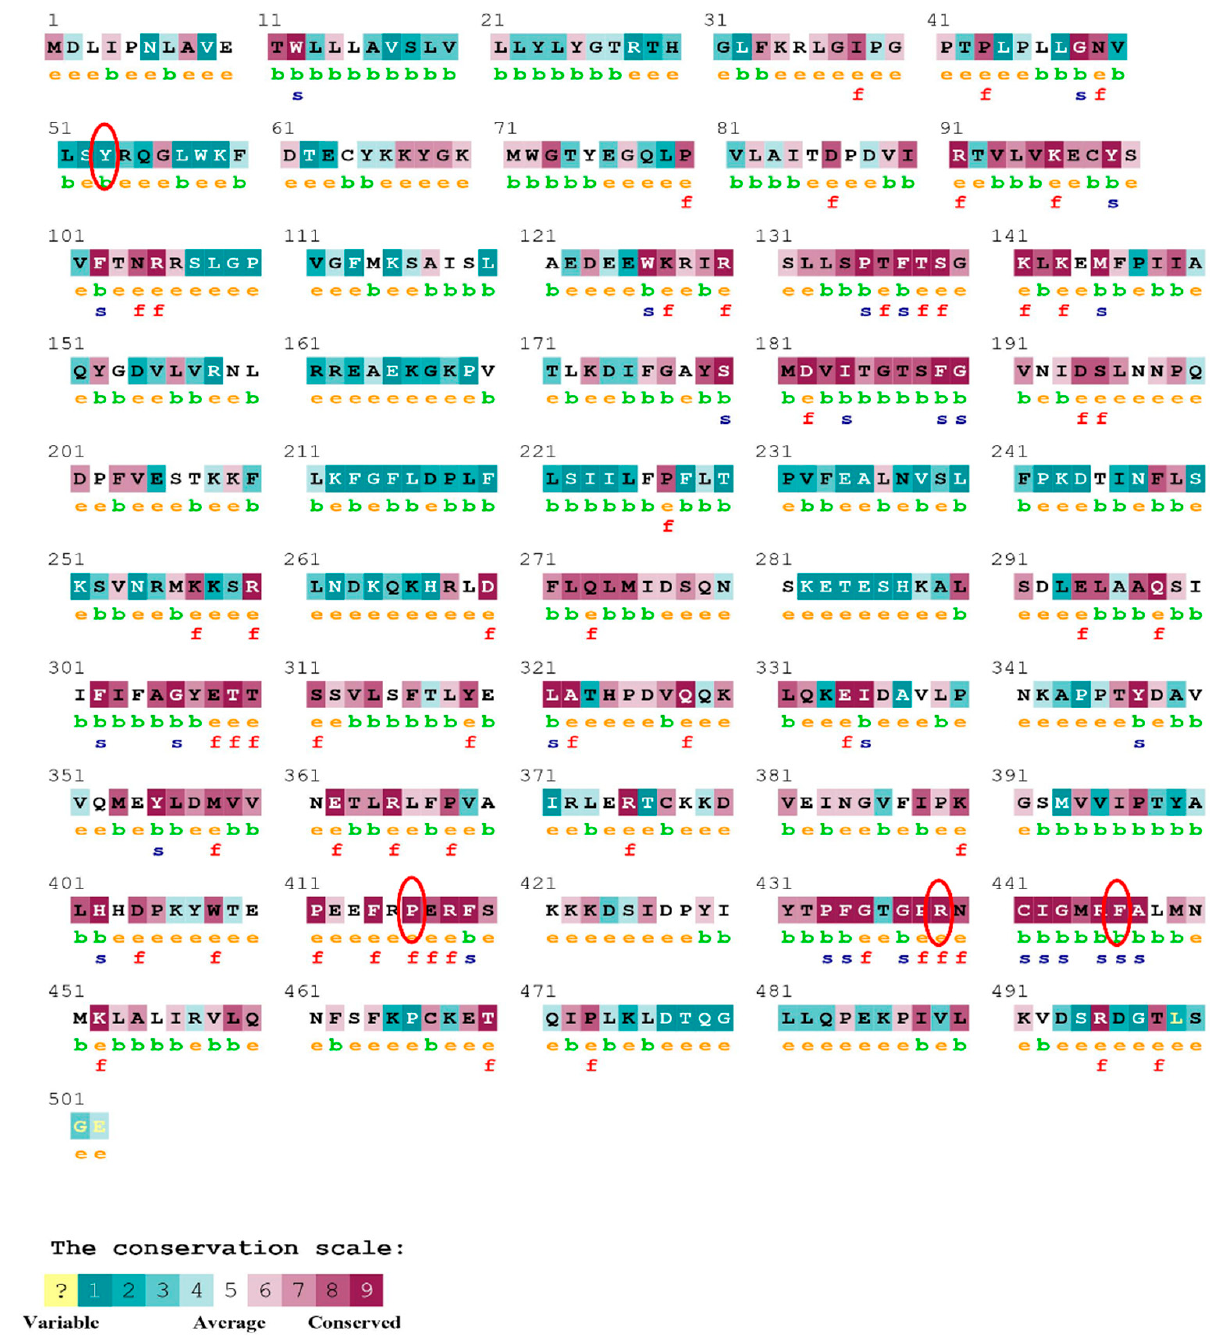
Figure 9. The ConSurf server predicted conserved amino acids in the CYP3A5 protein. Based on the conservation scale, the amnio acids are ranked as variable, average, and